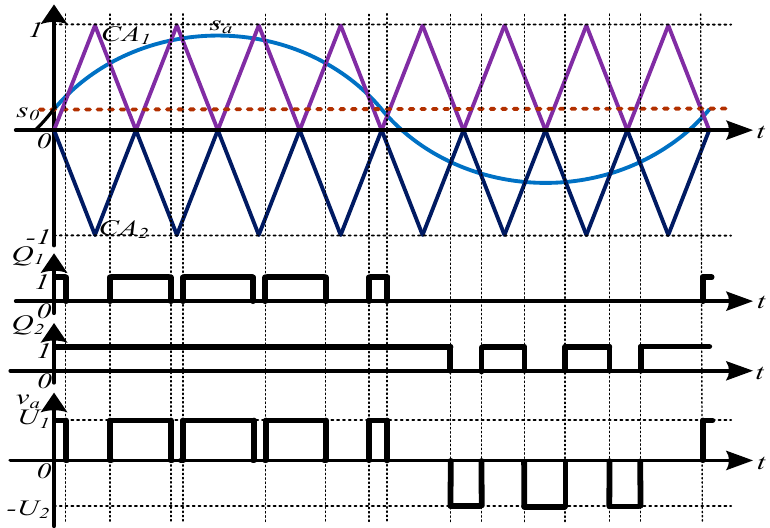
Figure 2. Alternative phase opposition disposition sine pulse width modulation (APOD-SPWM) strategy.